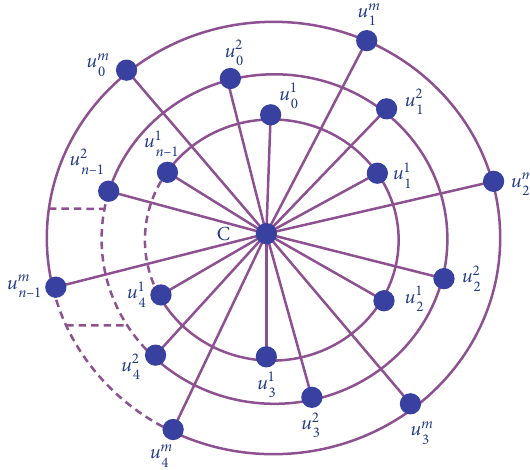
Figure 1: Multiwheel graph mW